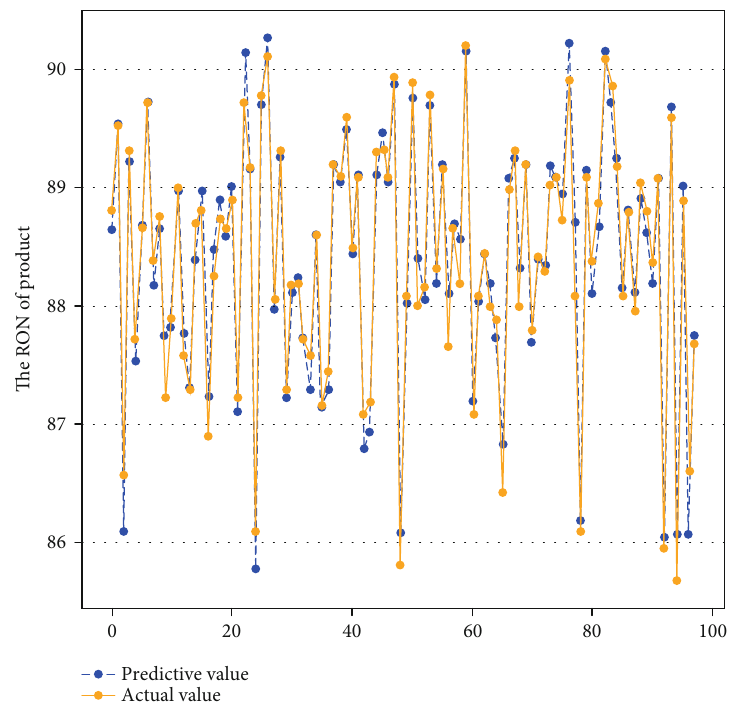
Figure 3: Fitting fi gure of PCA variable random forest model.